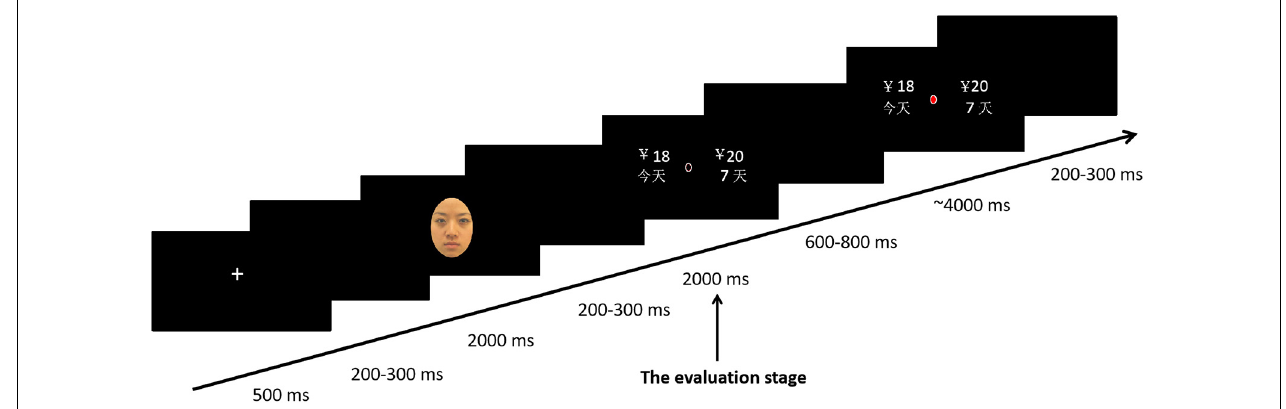
FIGURE 1 | Sequence of events in a single trial of the modified intertemporal choice